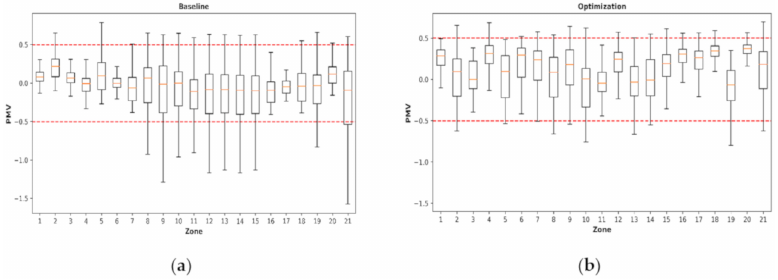
Figure 12. PMV in February following: ( a ) baseline’s strategy; ( b ) agent’s